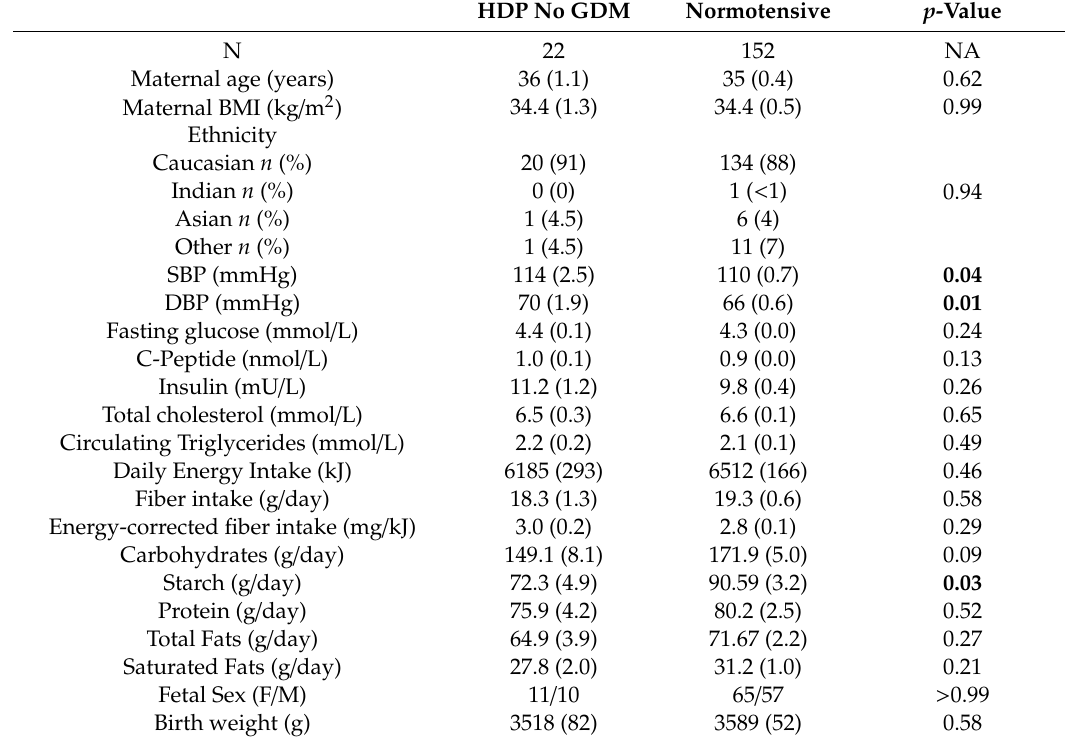
Table 2. Participant Characteristic HDP vs. Normotensive and HDP with no GDM vs. Normotensive Groups at 28 weeks